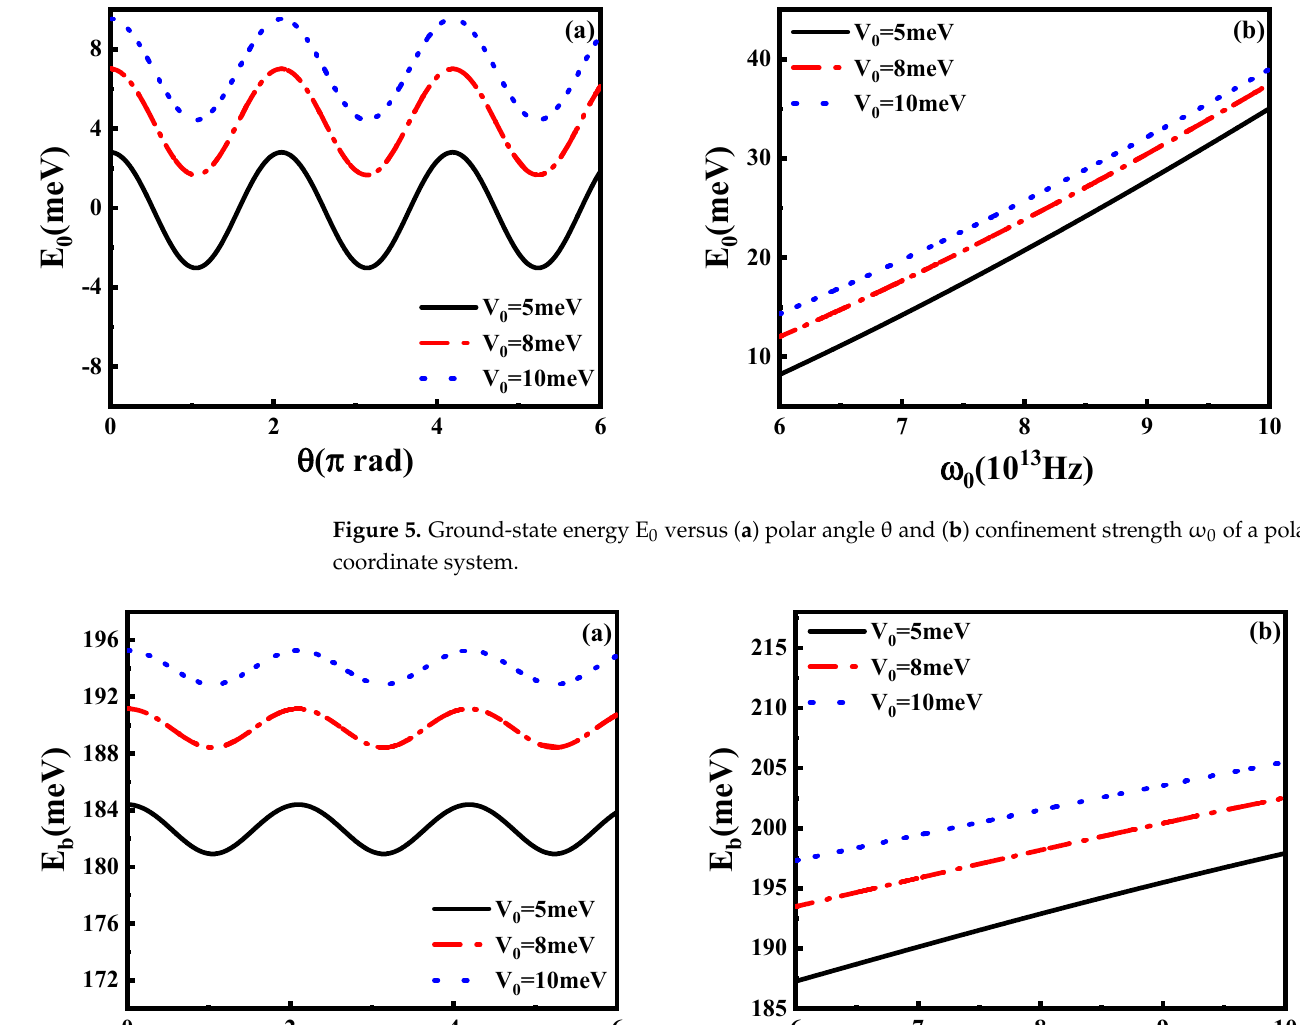
Figure 6. Ground-state binding energy E b versus ( a ) polar angle θ and ( b ) confinement strength ω 0 of a polar coordinate system. ω